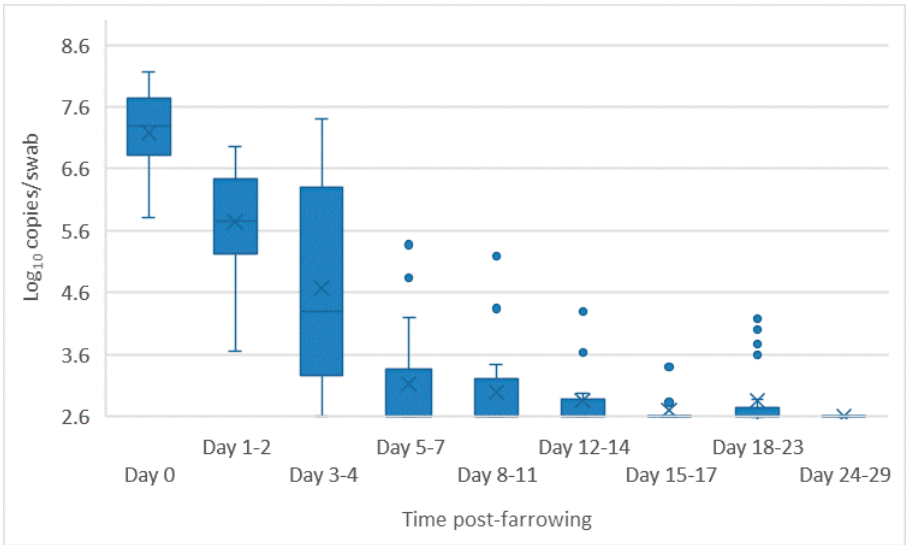
Figure 1. Box and whisker plot summarising the quantity of Bungowannah virus detected in vaginal swabs between 0–29 days post-farrowing following in utero infection (x = mean; — = median; the whiskers extend up from the top of the box to the largest data element that is less than or equal to 1.5 times the interquartile range (IQR) and down from the bottom of the box to the smallest data element that is larger than 1.5 times the IQR. Values outside this range are considered outliers and are represented by dots).